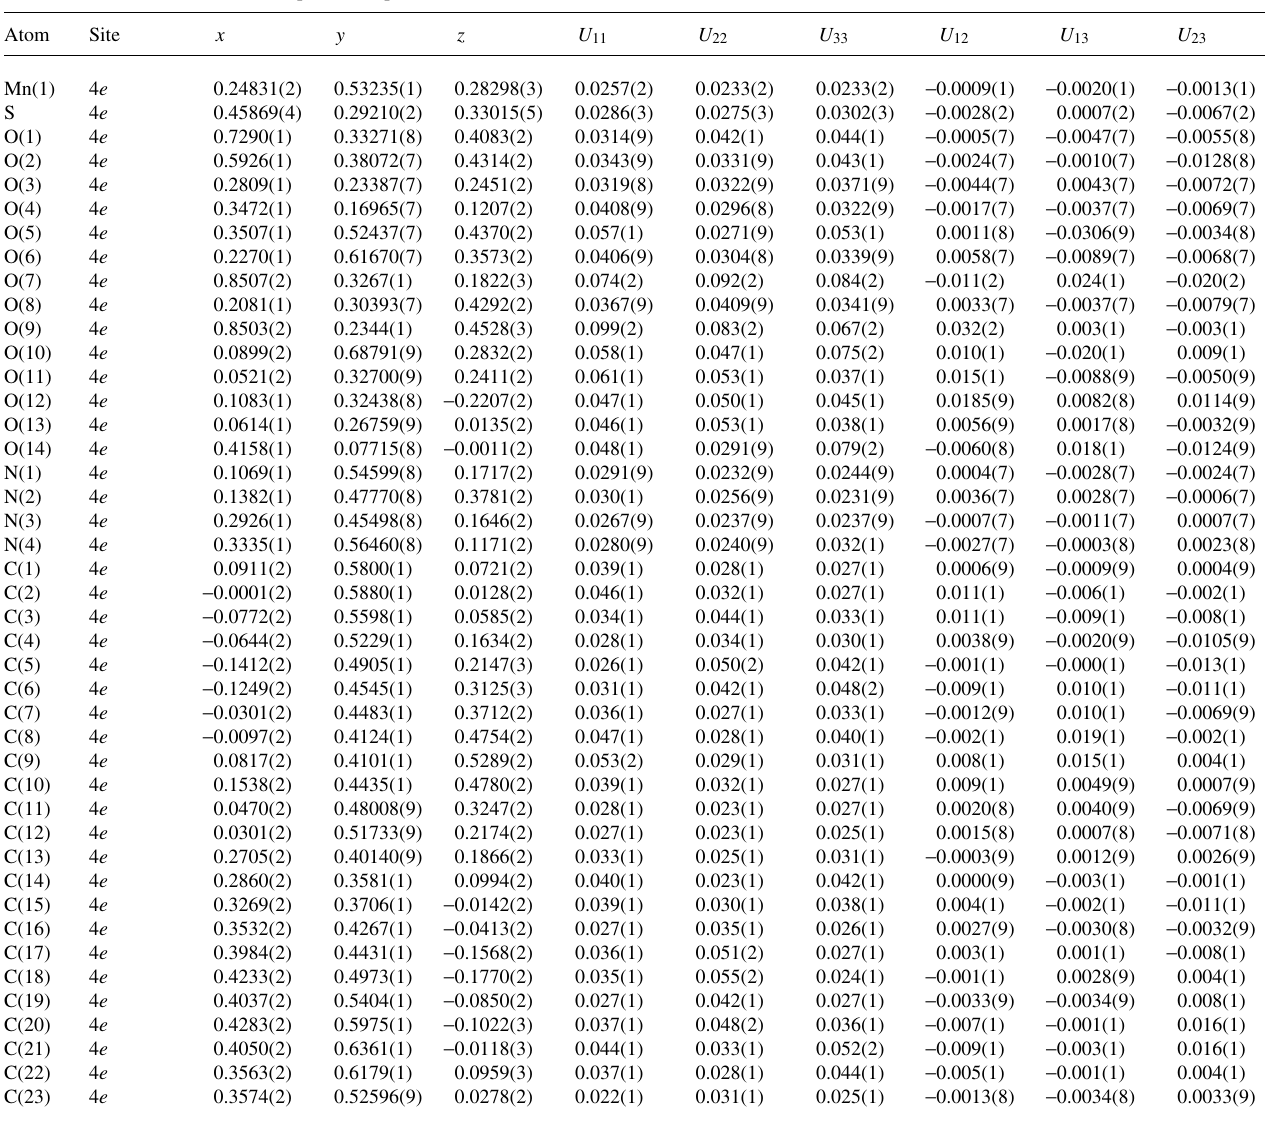
Table 3. Atomic coordinates and displacement parameters (in Å 2 ) .